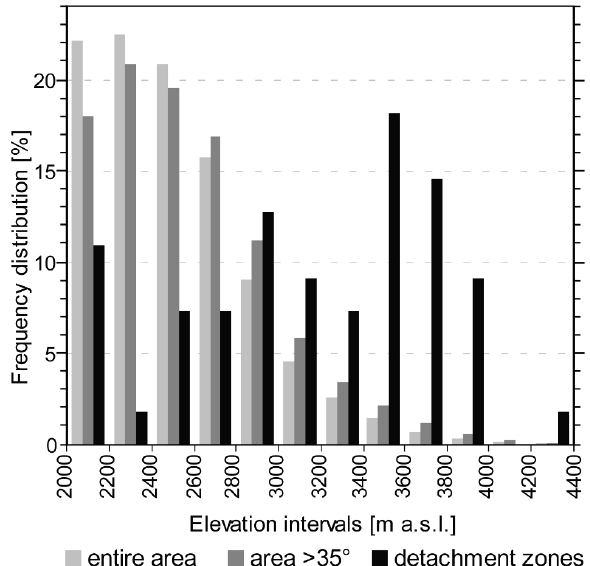
Fig. 6. Area distribution above 2000ma.s.l. with respect to ele- vation over the entire area including glaciers, areas with slope an- gle > 35 ◦ , which are considered as bedrock areas and detachment zones, calculated in 200m elevation